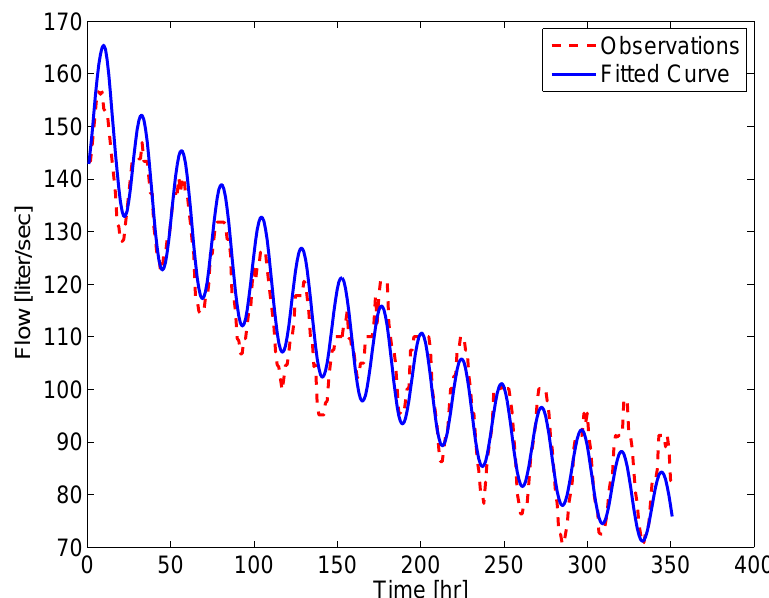
Figure 6. Observed streamflow in Dry Creek Experimental Watershed (location Lower Gauge). The data shown is from 1–15 July in 2011.